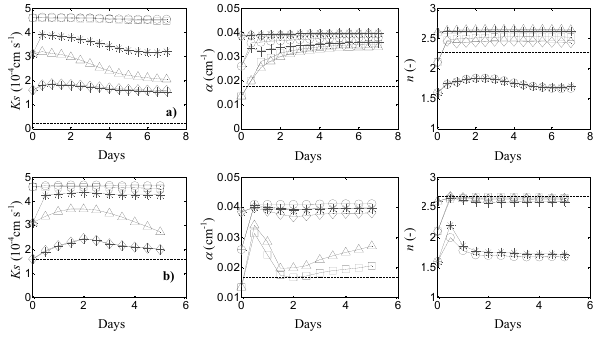
Figure 7. Retrieved VGM parameters K s , α and n using (a) GA3 and (b) GB1 experimental data, with assimilation frequency AF = 1/12h − 1 and observation depth OD = 1cm. Comparisons ac- count for the six pondered sets of initial parameters S1( (cid:13) ) , S2( (cid:3) ), S3( ∗ ) , S4( 1) , S5( + ) and S6( ♦ ) . The dotted line indicates the value of the parameter found by Romano and Santini